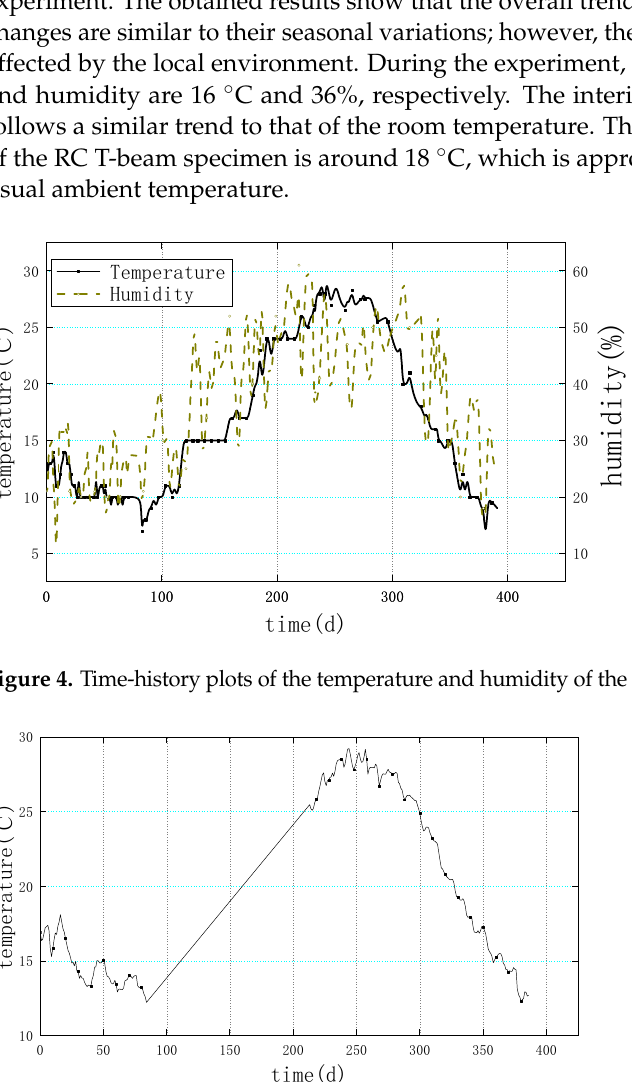
Figure 5. Time ‐ history plots of the temperature inside the T ‐ beam specimen. Figure 5. Time-history plots of the temperature inside the T-beam